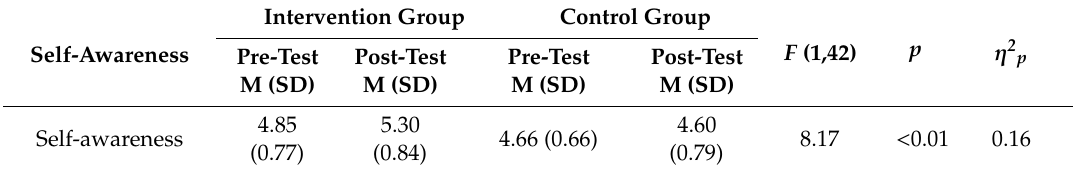
Table 3. Self-awareness of the present-moment experience (Mindful Attention Awareness Scale, MAAS).